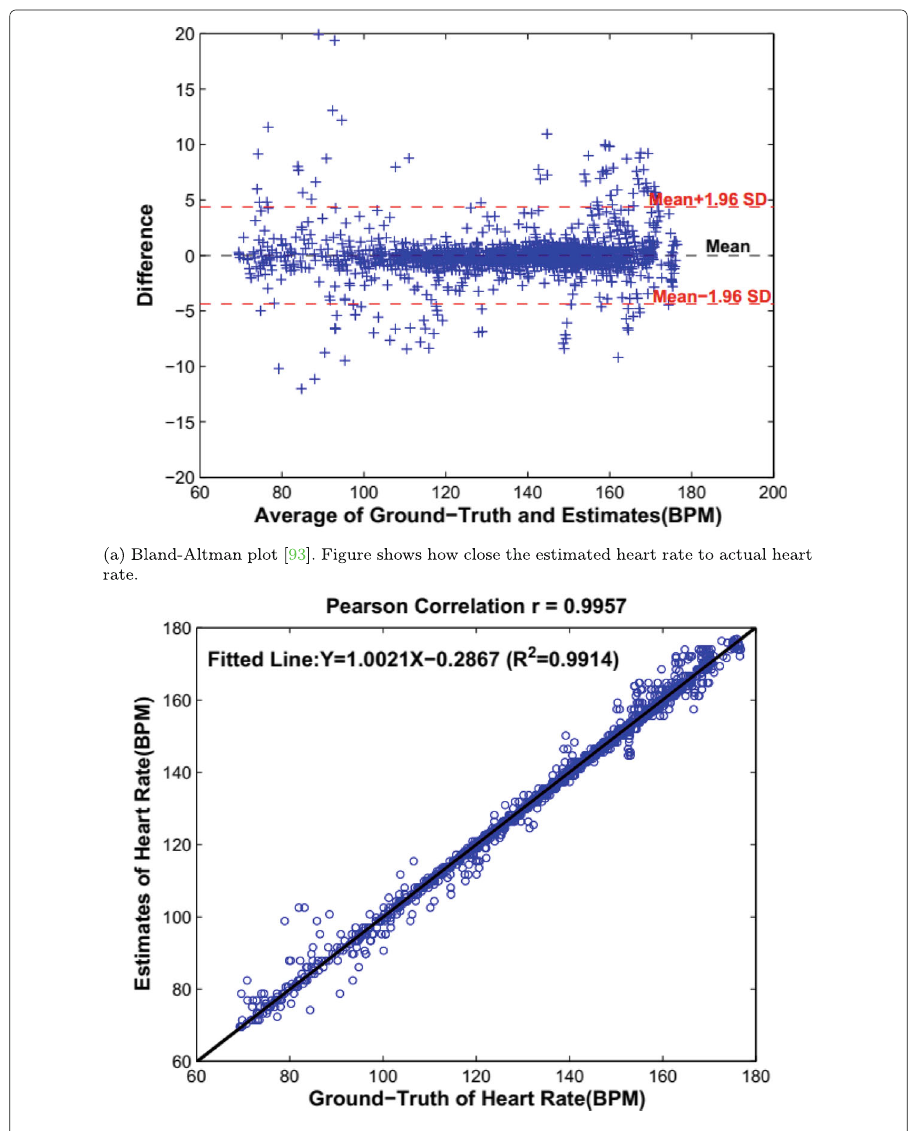
Fig. 6 Pearson correlation calculation and plotting [43]. The figure shows how close the estimated heart rate to the actual heart rate